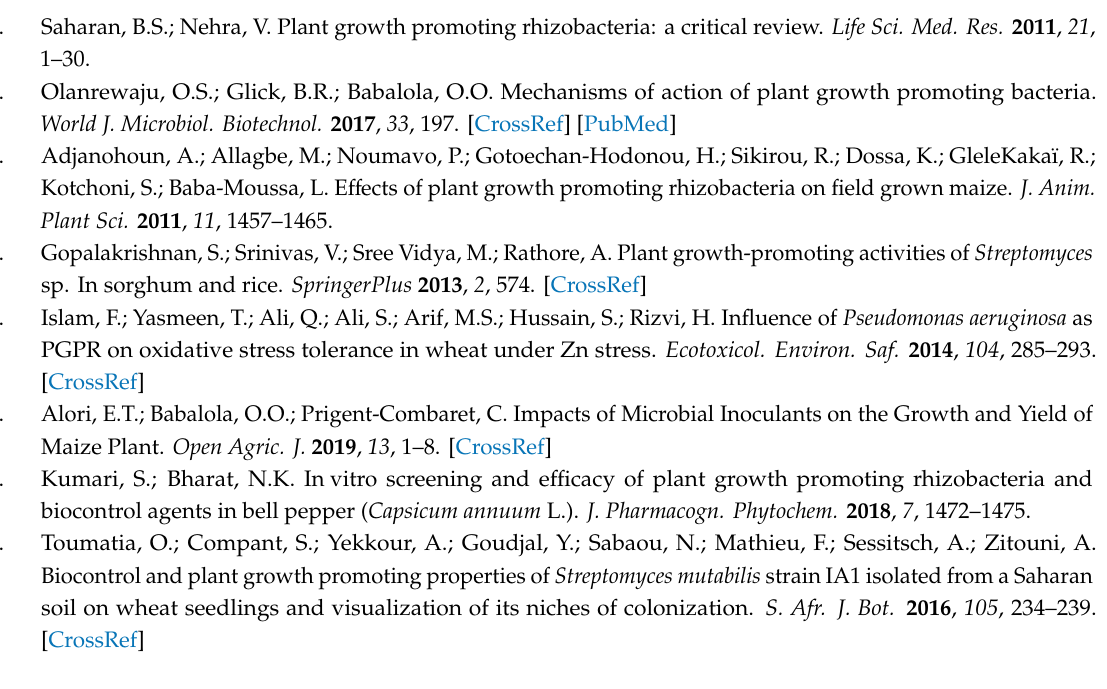
Figure S1: Factor map showing the clustering of the treatments into 3